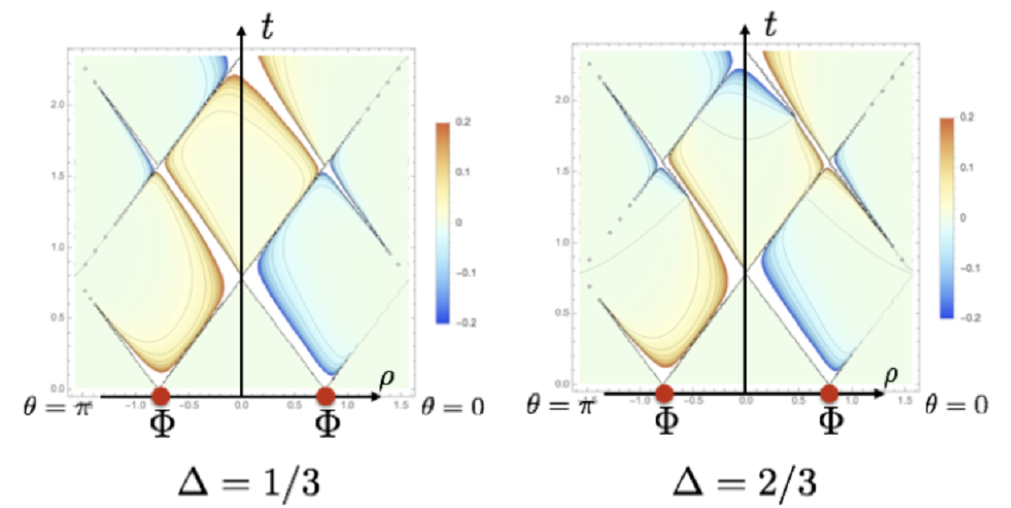
Figure 6 . Plots of null energy T UU in the bulk on (cid:18) = 0 (and = (cid:25) ) plane. U is taken to be (cid:18) growing direction. We can observe non zero null energy is emitted from the two points where we inserted double trace deformation. Note that on any null geodesic incoming from (cid:18) = (cid:25) and (cid:0) (cid:25) < (cid:18) < 0, null energy is negative, when g is positive. This fact is (cid:1) independent. The left (cid:12)gure is for (cid:1) = 1 = 3 case, and the right (cid:12)gure is for (cid:1) = 2 = 3 case.